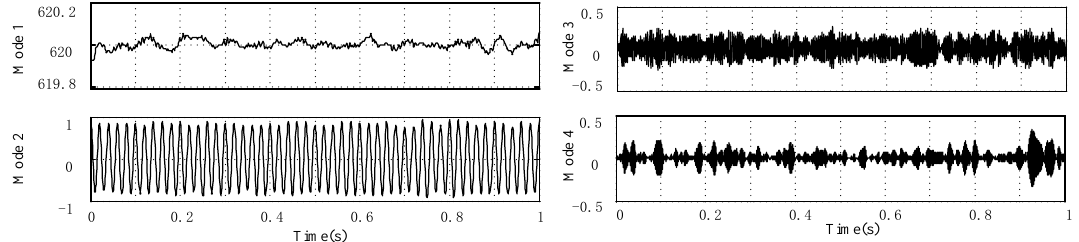
Figure 22. The decomposed modes of VMD-HT algorithm (mode1: DC value 620 V, mode 2: 50 Hz, mode 3:250 Hz, mode 4: 350 Hz).